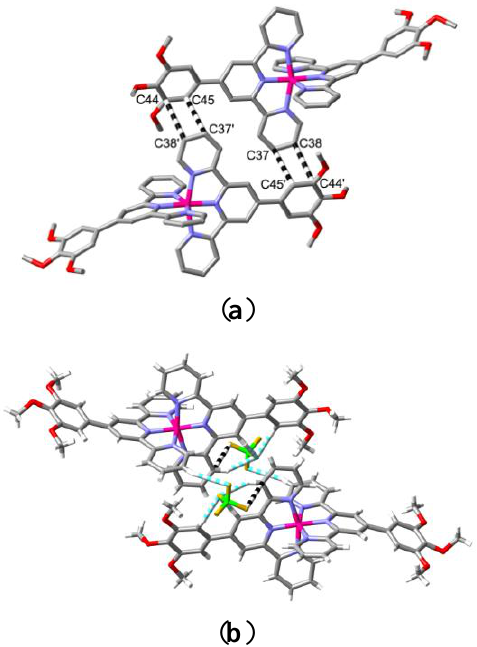
Figure 2. ( a ) Reciprocal π-type interactions (dashed lines) between trimethoxyphenyl- and pyridyl-group carbon atoms of cations (stick representations; H-atoms not shown) with Co…Co 10.621(3) Å within the lattice of [Co( L1 ) the same pair of cations as in (a) via interactions with tetrafluoroborate anions of both CH…F (blue and white dashed lines) and F…π (black and white dashed lines) types.